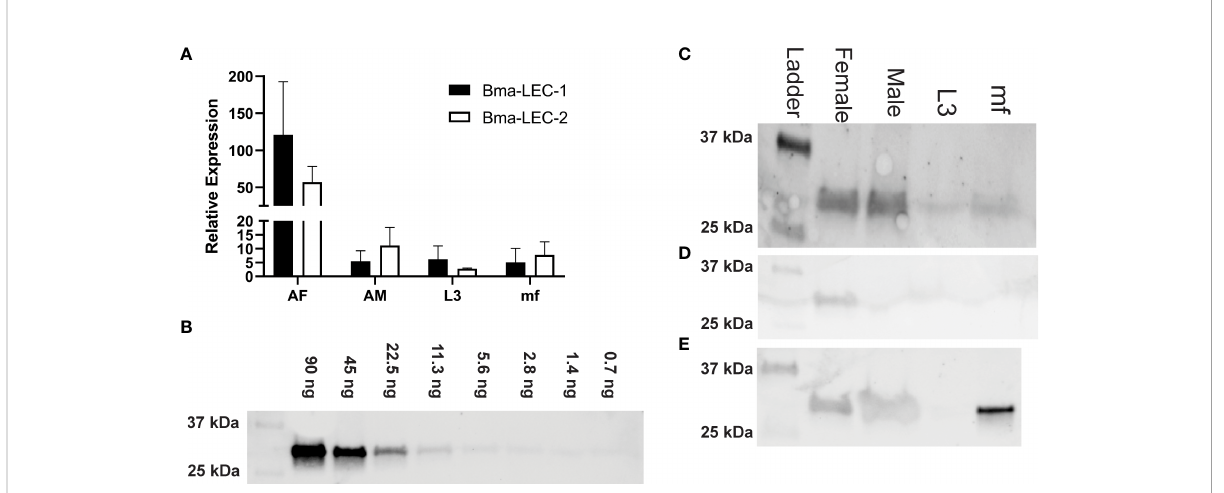
FIGURE 1 Bma-LEC-1 and Bma-LEC-2 expression and secretion are sex- and life stage-speci fi c. (A) Bma-LEC-1 and Bma-LEC-2 are most highly expressed in adult female stage parasites. (B) A monoclonal antibody raised against Bma-LEC-2 (34) can detect recombinant Bma-LEC-2 (approximately 32 kDa) at quantities as low as 3 ng. (C) Using this antibody, parasite galectin reactivity was predominantly detected in whole worm lysate of adult female parasites and to a lesser extent in adult males and micro fi lariae. (D) Parasites also secrete galectins into the extracellular milieu and galectin reactivity was detected in isolated extracellular vesicles (EVs) of adult female parasites and (E) in EV-depleted spent culture media of micro fi lariae and to a lesser extent adult female and male parasites. Representative images of three biologically distinct